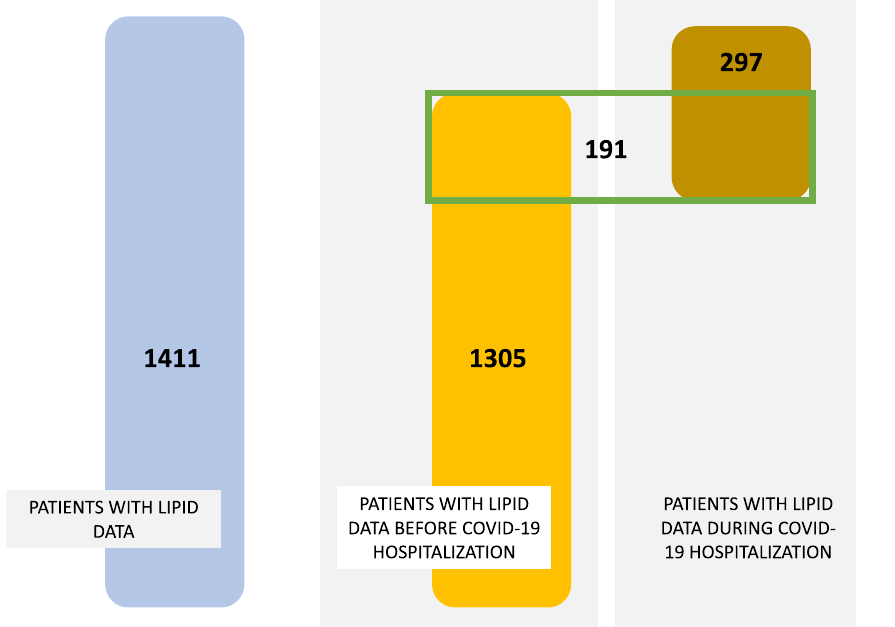
Figure 1. Distribution of patients included in the study according lipid profile